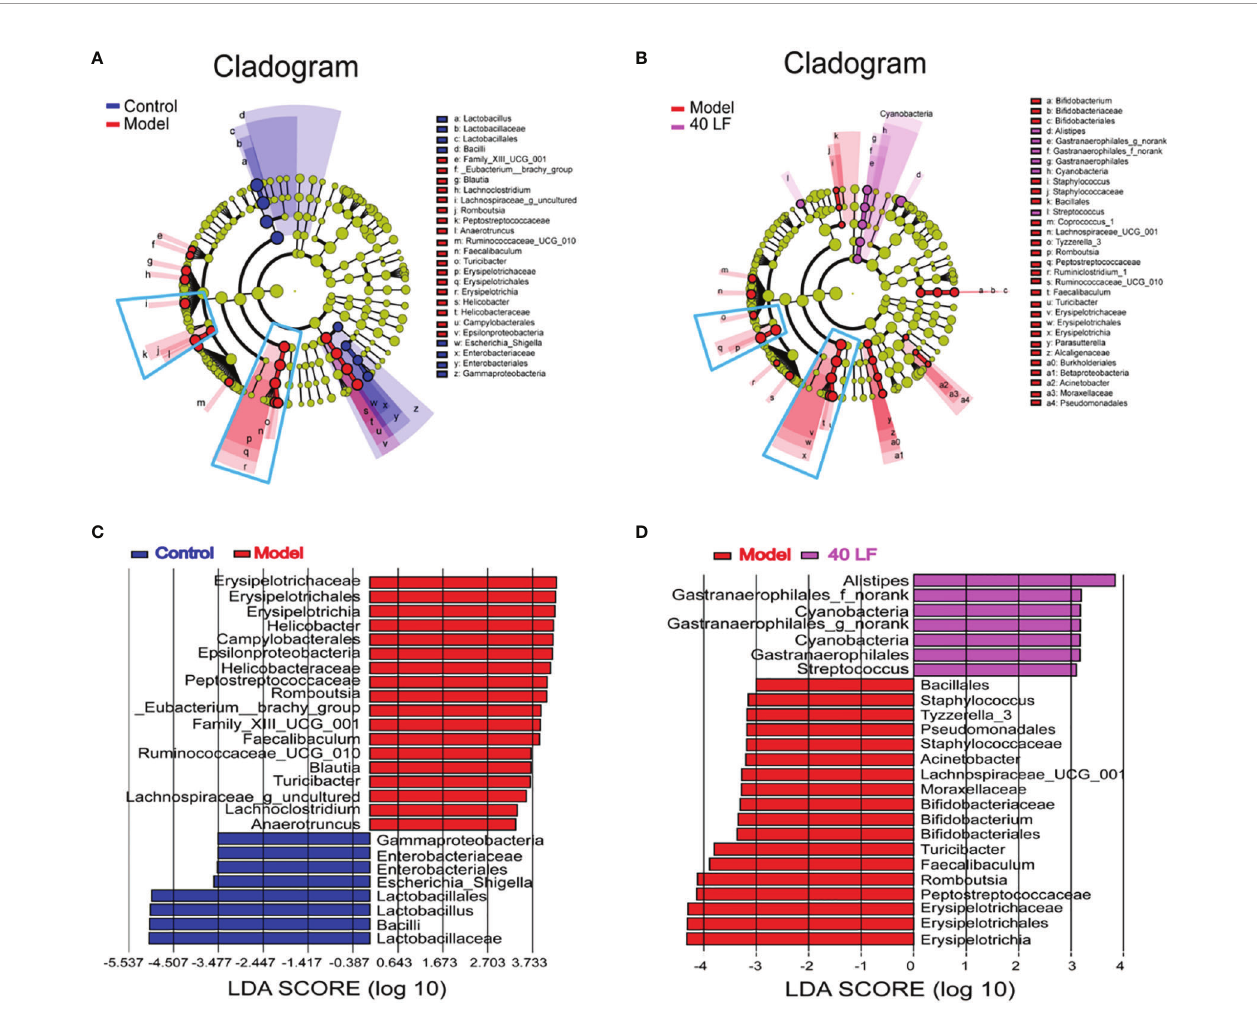
FIGURE 7 | The LEfSe and Spearman correlation analyses of the fecal microbes of the different mice groups ( n = 4). (A) LEfSe analysis showing the key differential microbes of the CTX-induced mice. (B) LEfSe analysis showing the key differential microbes of the CTX-induced immunosuppressed mice subjected to the 40 LF intervention. (C) The LDA score between the control and the model groups. (D) The LDA score between the model and the 40-LF treated